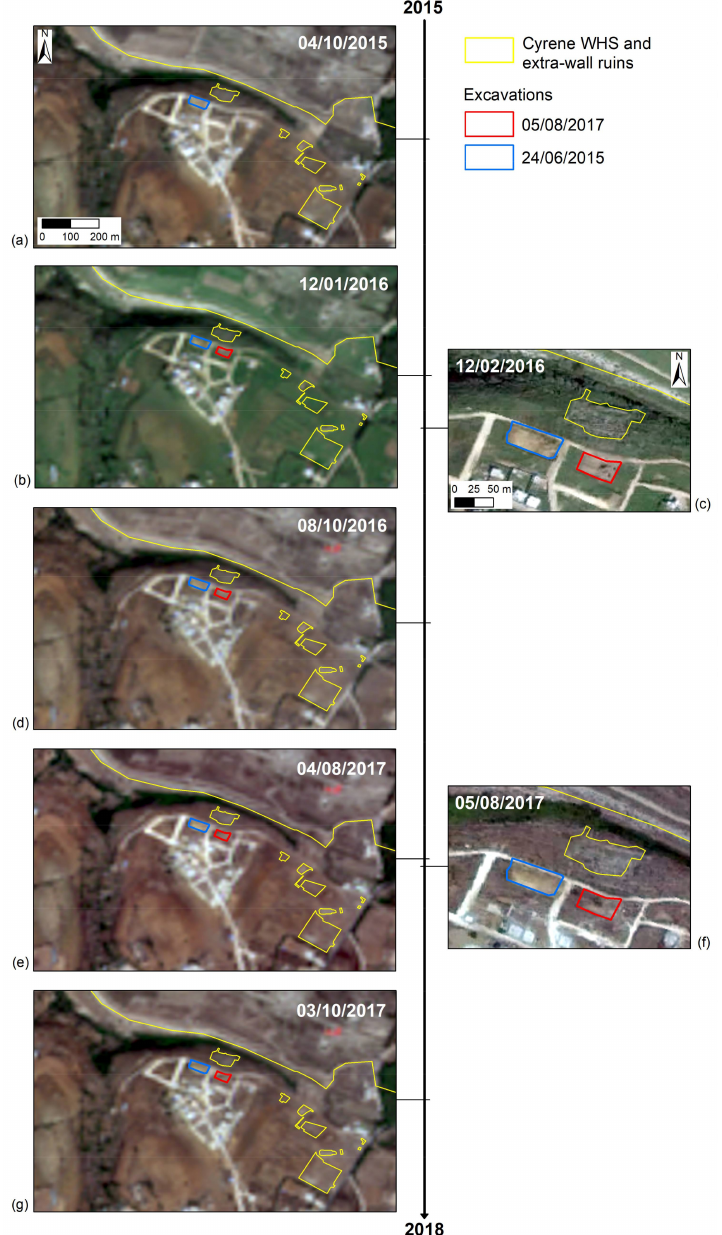
Figure 8. The evolution of the block feature detected in the proximity of the Sanctuary of Demeter and Kore, south of the Cyrene WHS hilltop site, based on Sentinel-2 time series: ( a ) 4 October 2015; ( b ) 12 January 2016 compared with ( c ) the VHR Google Earth image taken on 12 February 2016; ( d ) 8 October 2016; ( e ) 4 August 2017 compared with ( f ) the VHR image taken on 5 August 2017; and ( g ) 3 October 2017. Copernicus Sentinel-2 images in ( a , b , d,e , g ) © 2015–2017 European Space Agency—ESA; Google Earth images in ( c , f ) © 2018